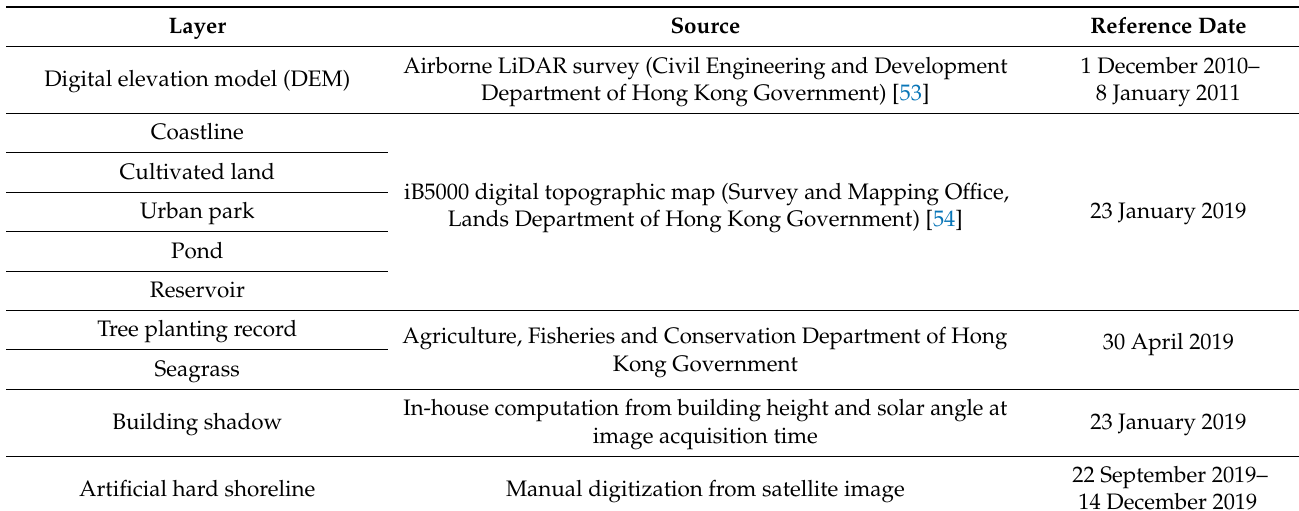
Table 2. List of ancillary local geographic information system (GIS) data applied in this study. The reference dates refer to dates of light detection and ranging (LiDAR) data collection (for DEM), image acquisition (for artificial hard shoreline) and last update dates of the GIS database (for other layers).